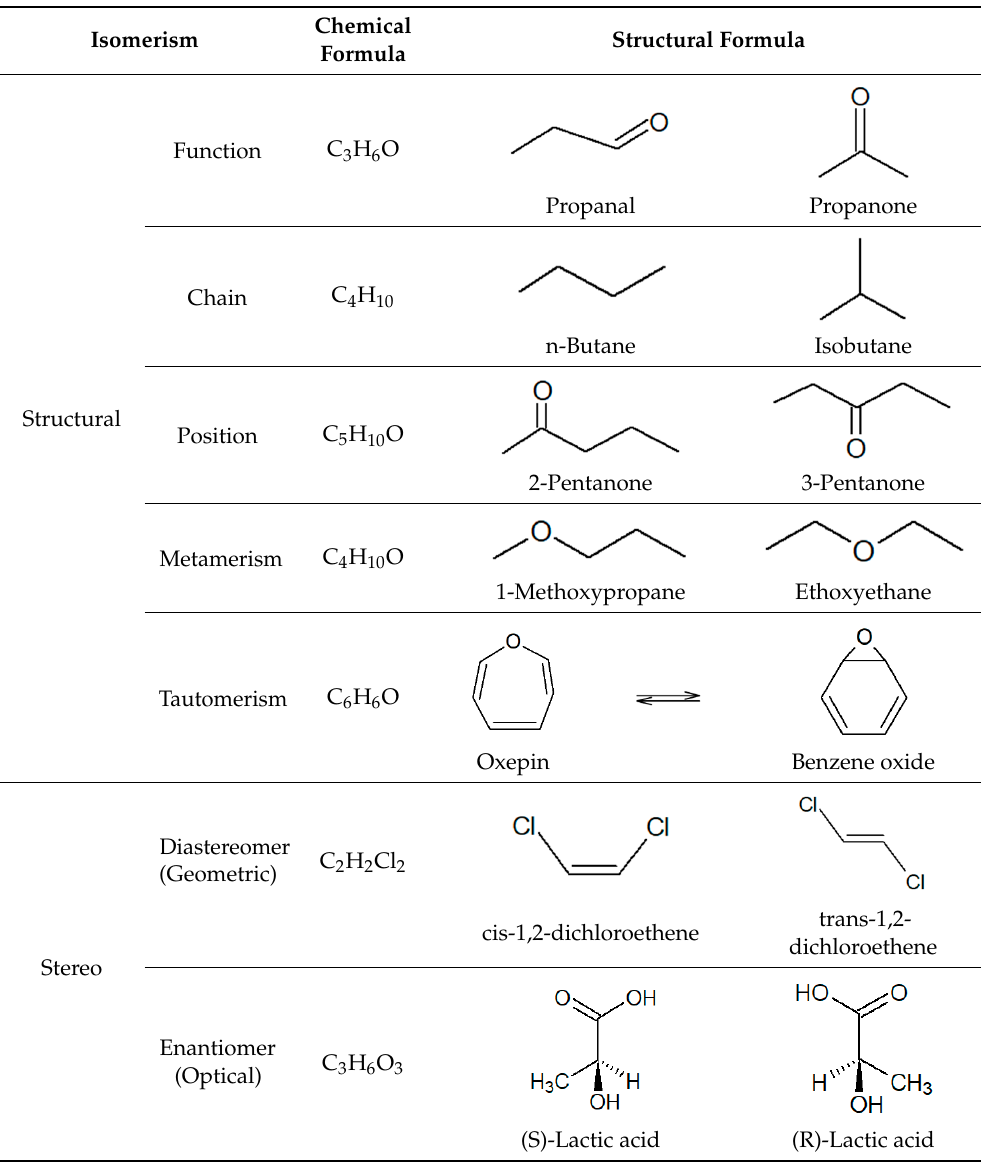
Table 1. Types of isomers and their structural formula [3].